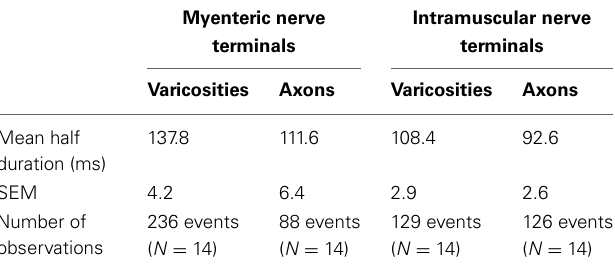
Table 2 | Characteristics of time-to-peak of calcium transients in varicosities and axons of spinal afferent nerve terminals that ramify within myenteric ganglia and circular